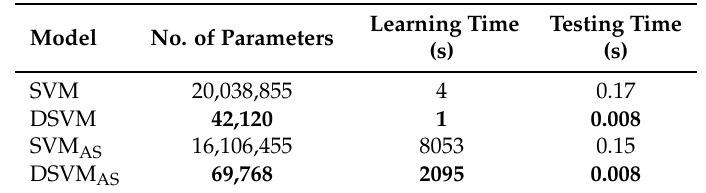
Table 9. Number of parameters and the times in seconds needed for learning and testing on the 512 × 512 resolution scenes. The bold values simply indicate the minimum values obtained by the